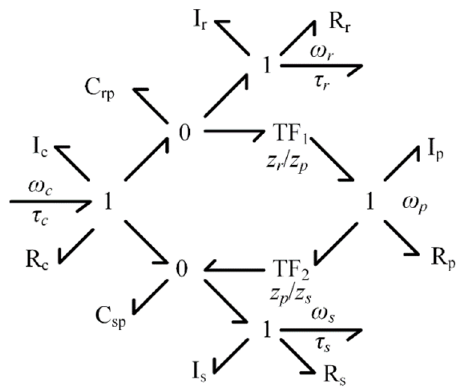
Figure 3. BG model of the S-PGT.